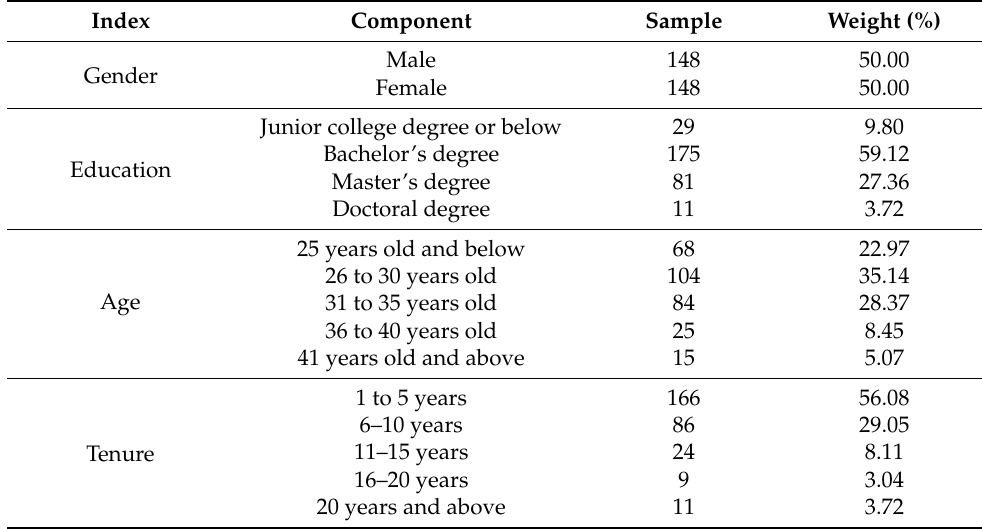
Table 1. Basic information of the